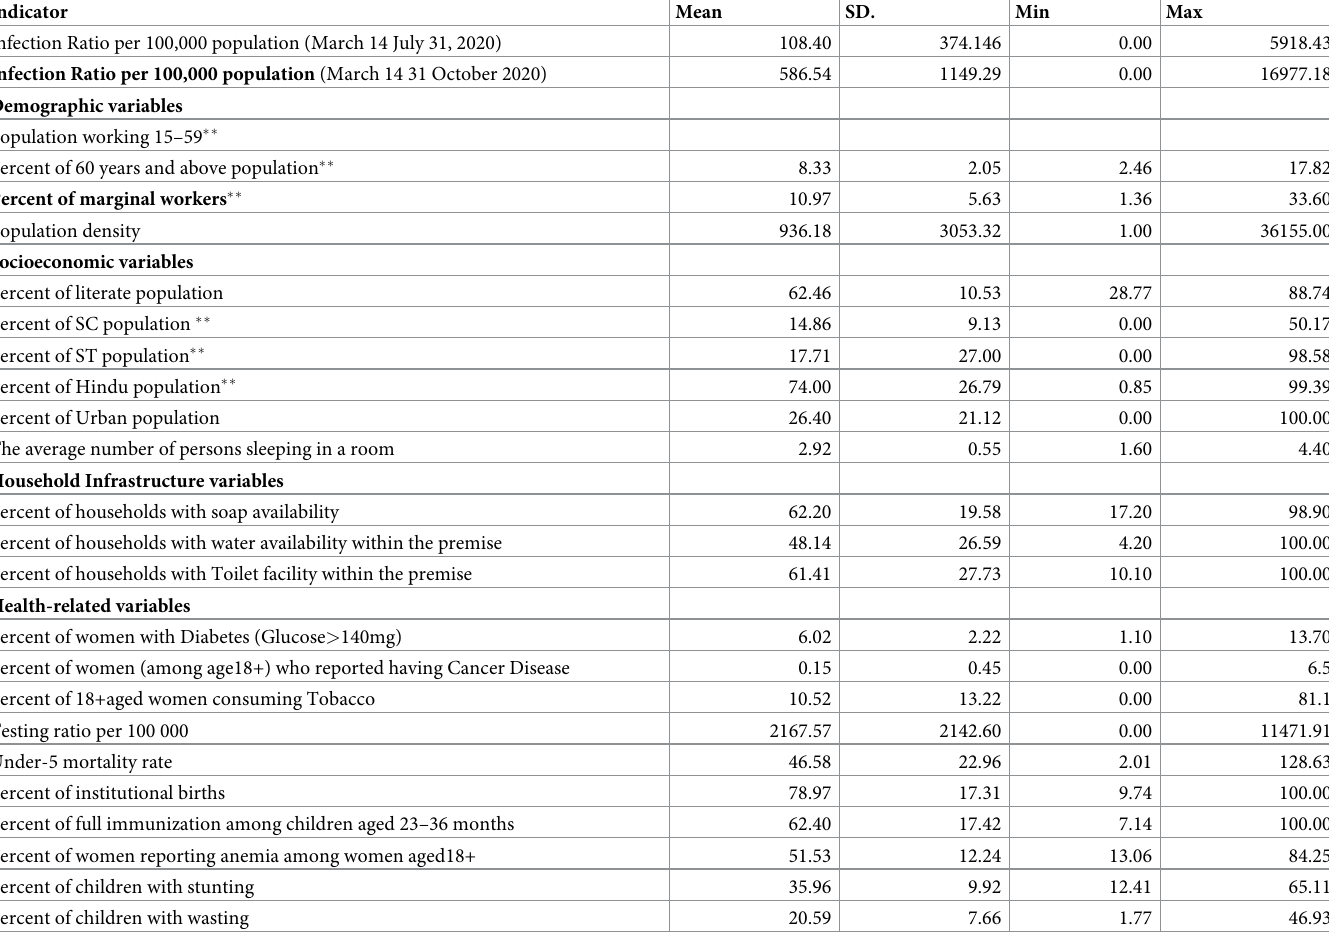
Table 1. Summary statistics for the outcome and explanatory variables across 640 districts of India.